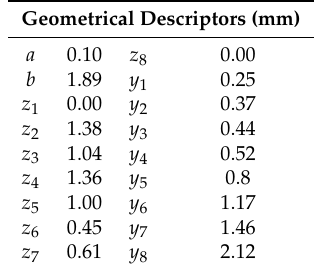
Table 2. HDI-based patch radiator (